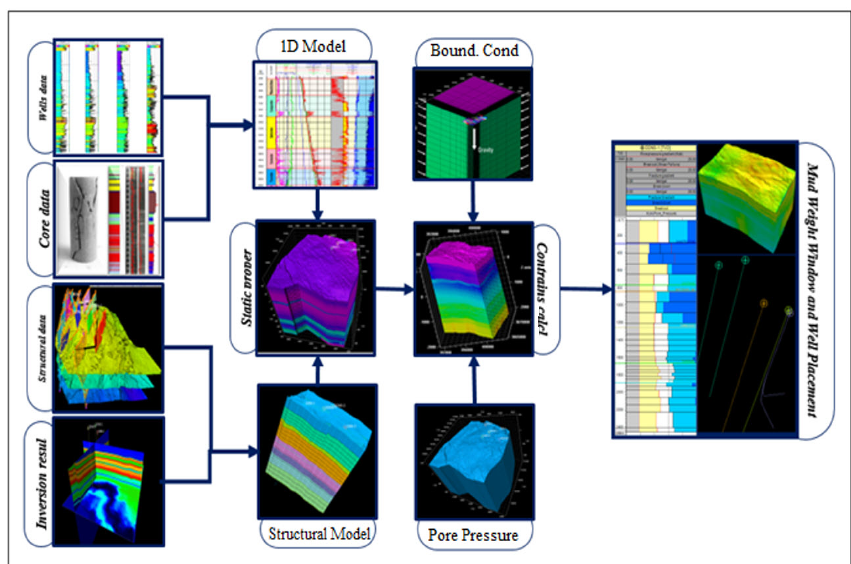
Figure 7. Workflow of the 3D geomechanical model construction.